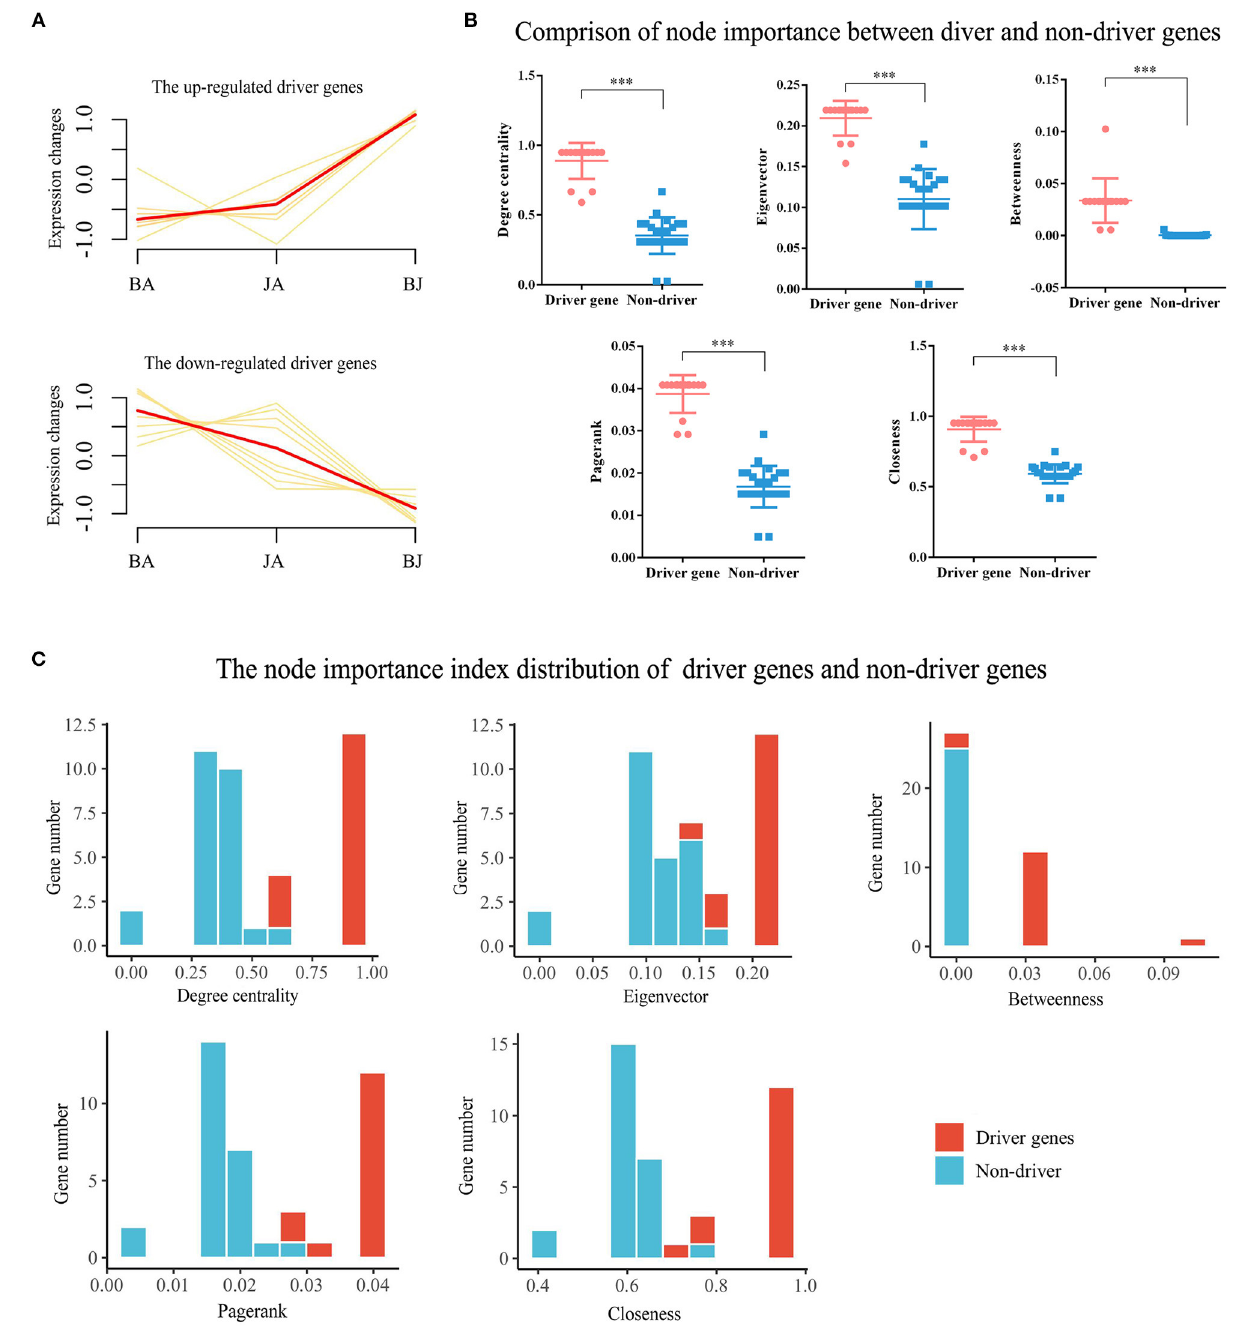
FIGURE 5 | Validation the roles of driver genes. (A) The expression changes of driver genes in the three-drug groups. (B) The comparison of driver genes and non-driver genes on 5 node importance indicators, *** p < 0.001. (C) The decile interval distribution of driver and non-driver genes based on the network node importance indicators of degree centrality, eigenvector, betweenness, PageRank, and